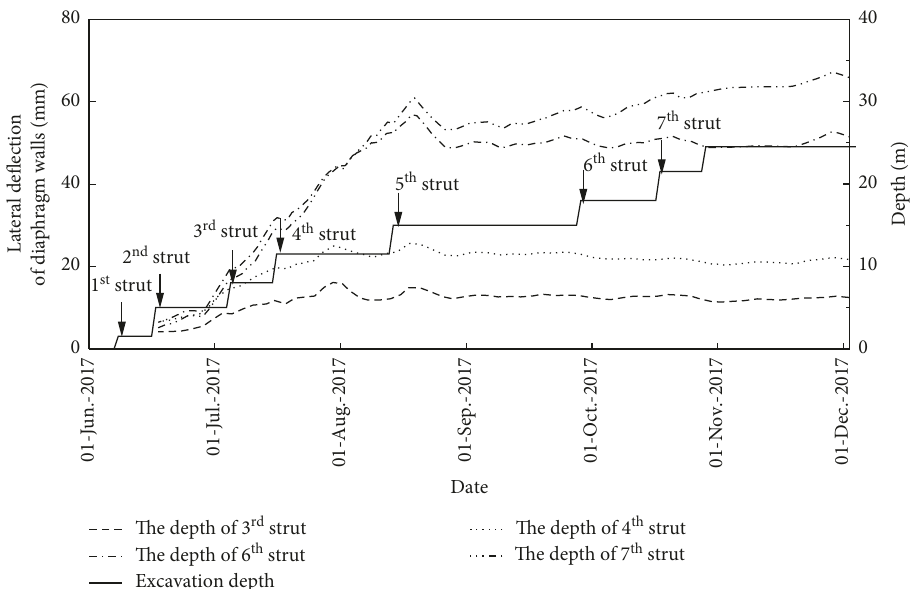
Figure 19: Curve of the lateral deformation at the elevation of the servo support with respect to